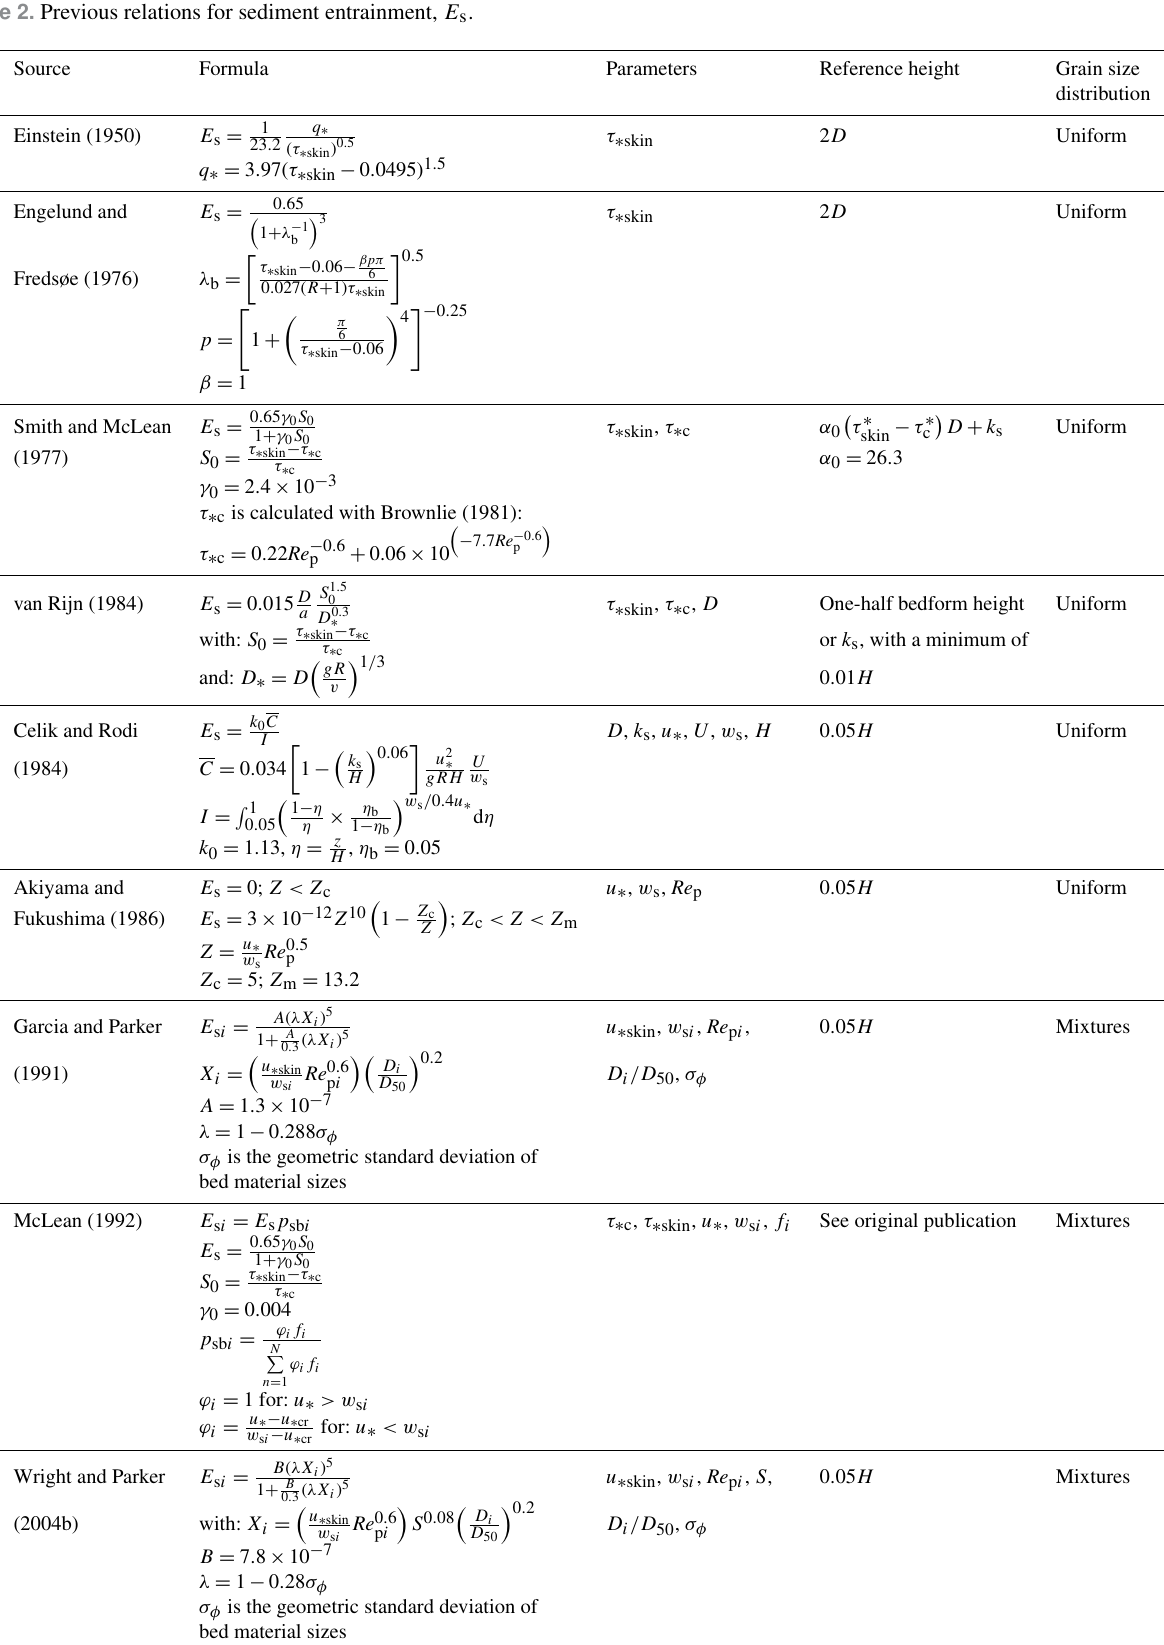
Table 2. Previous relations for sediment entrainment, E s .